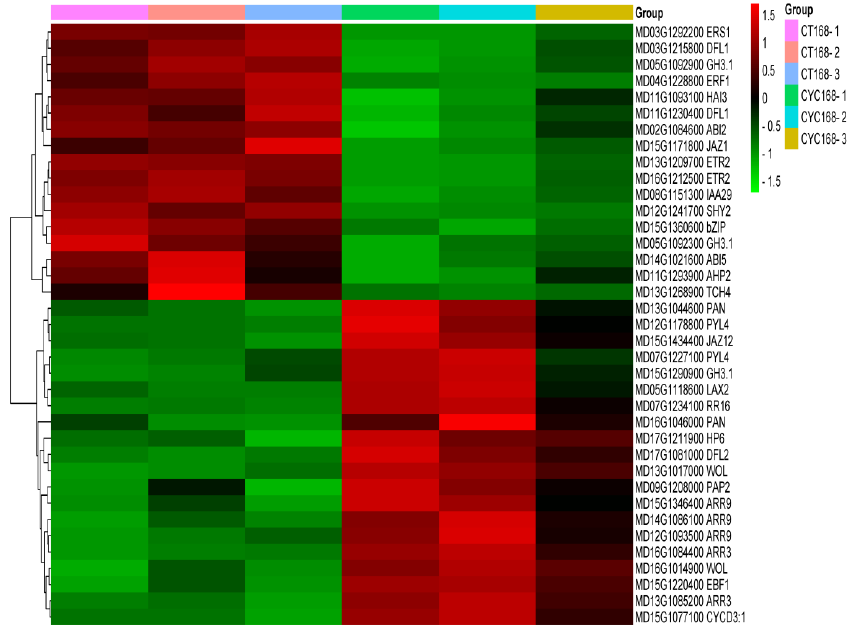
Figure 7. The heatmap of 37 genes involved in the plant hormone signal transduction pathway.